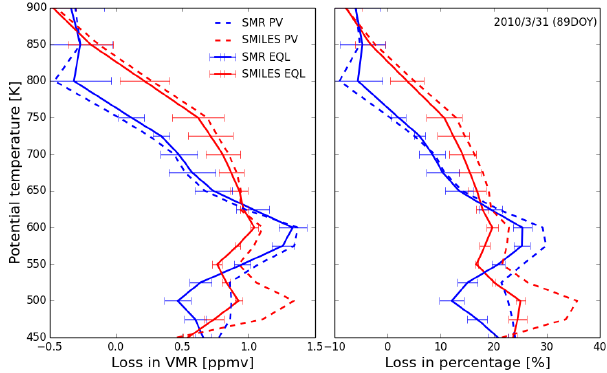
Fig.12: Sameasfigure11butfor31March2010. Figure 12. Same as Fig. 11 but for 31 March 3 ± ≥ 38PVU). ≥